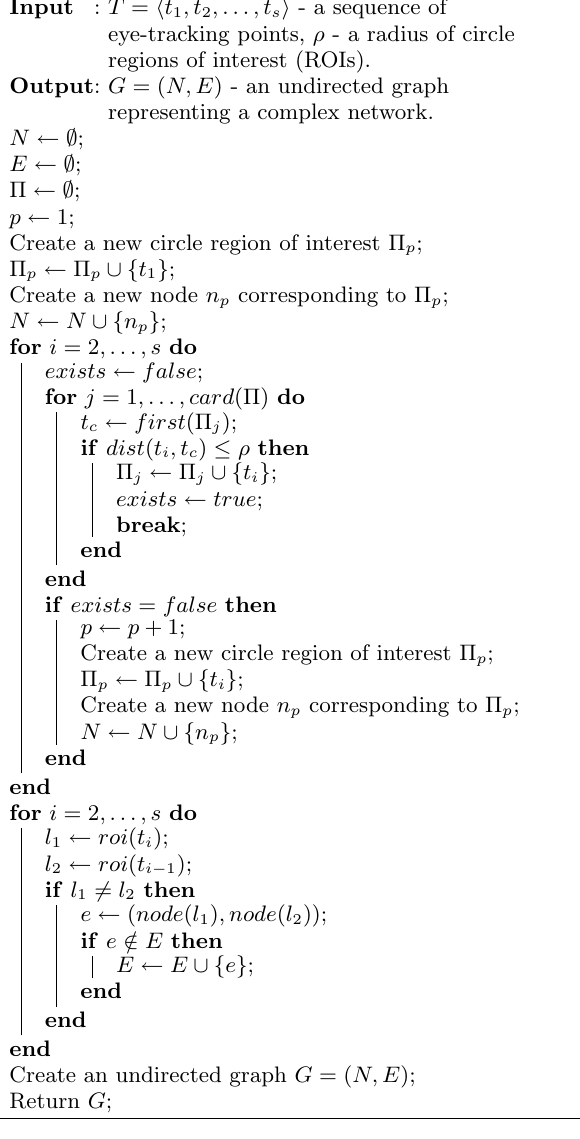
Algorithm 1 : Algorithm for transformation of a se- quence of eye-tracking points into an undirected graph representing a complex